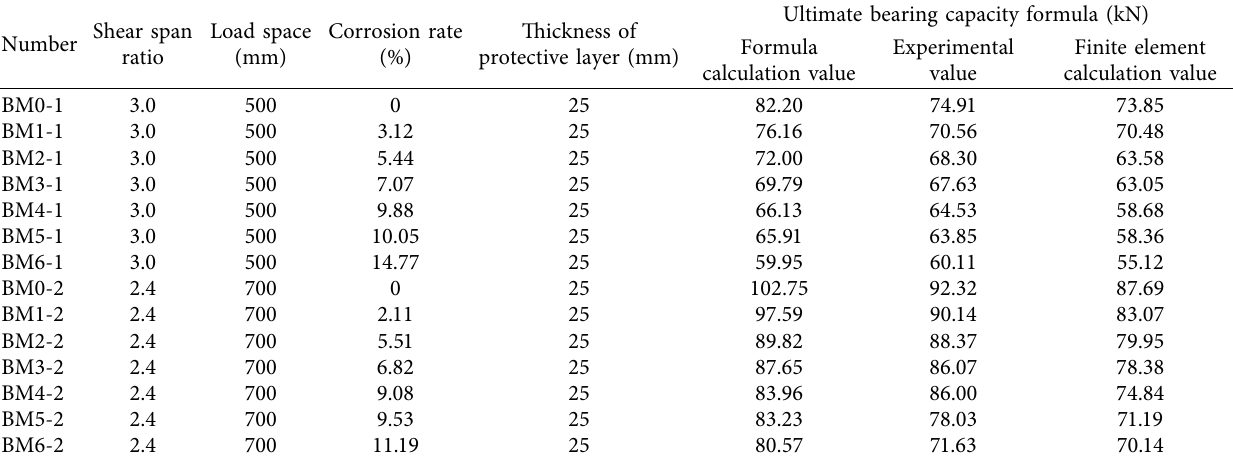
Table 3: Comparison of ultimate bearing capacity of RC members with different corrosion